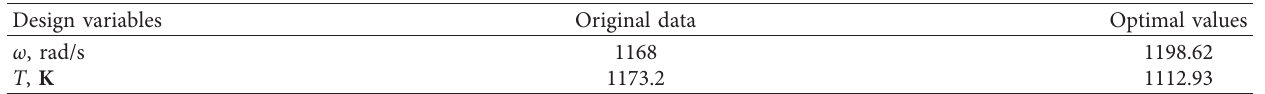
Figure 4: Distributions of blade deformation before and after optimization. Table 3: Optimization results of overall blade failure.